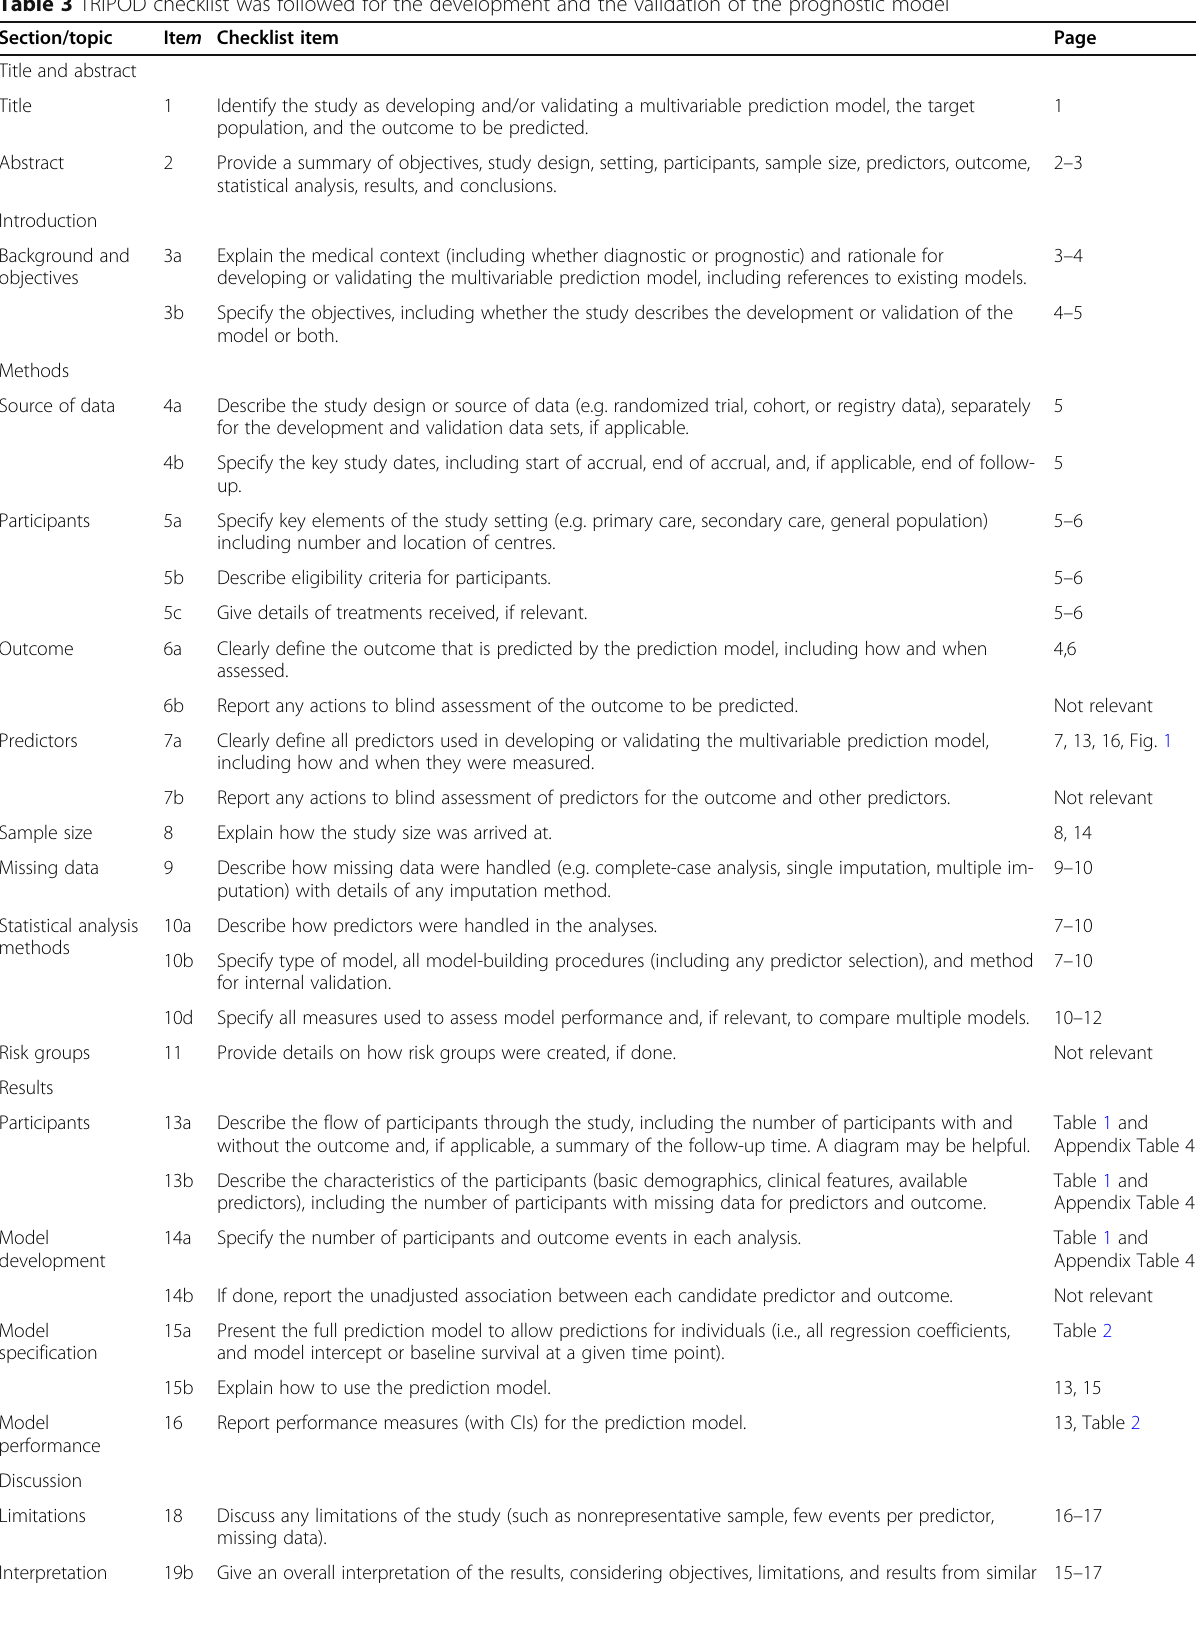
Table 3 TRIPOD checklist was followed for the development and the validation of the prognostic model